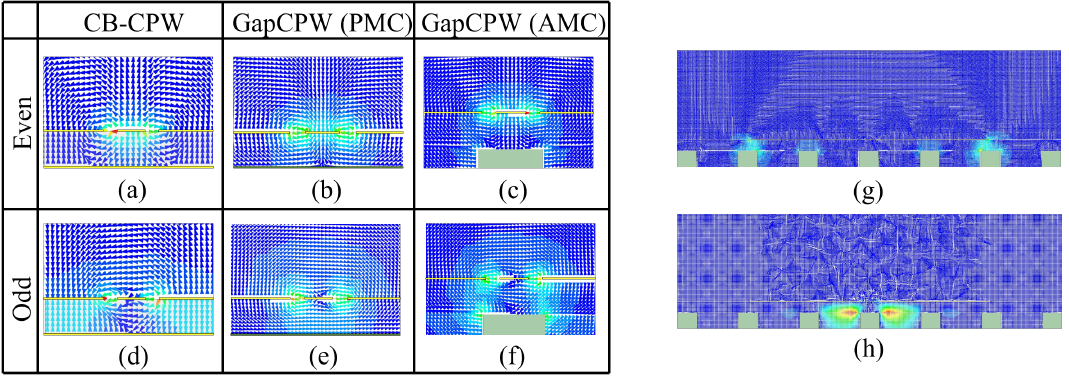
Figure 8. Screenshots from HFSS Eigenmode simulator concerning the E-field arrangement in different modes. ( a – c ) coplanar even mode for different bottom boundary conditions: PEC (CB-CPW), PMC, and AMC, respectively. ( d – f ) coplanar odd (slotline) mode. ( g ) E-field arrangement for the highest LOM (low order mode) at the GapCPW. ( h ) E-field arrangement for the lowest HOM (high order mode) in the GapCPW.